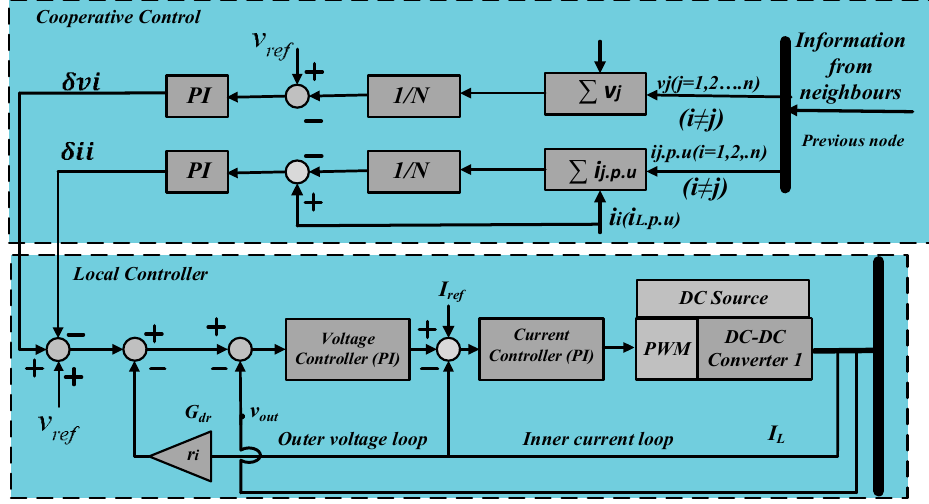
Figure 1. Conventional droop-based technique [12].